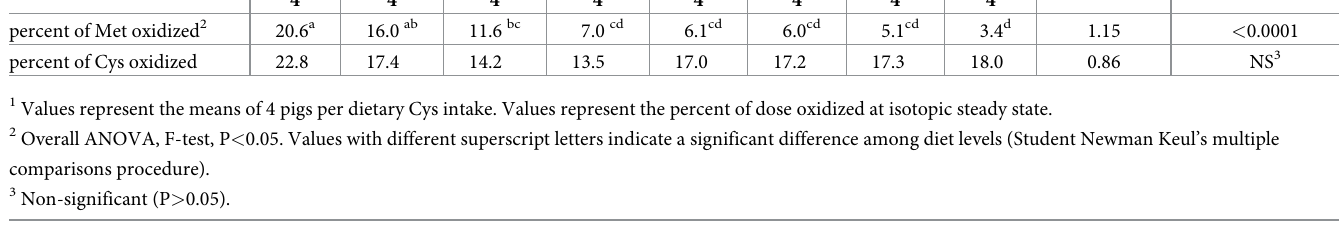
Table 1. 14 CO 2 from L-[1- 14 C]Met and L-[1- 14 C]Cys in piglets receiving total enteral nutrition with graded levels of dietary Cys and 0.25 g kg -1 d -1 Met 1 .